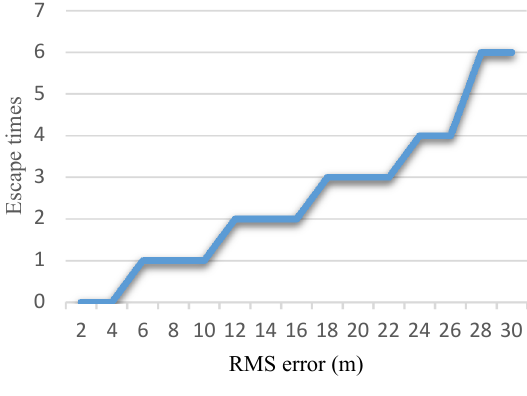
Figure 8. Escape times vs. RMS error.